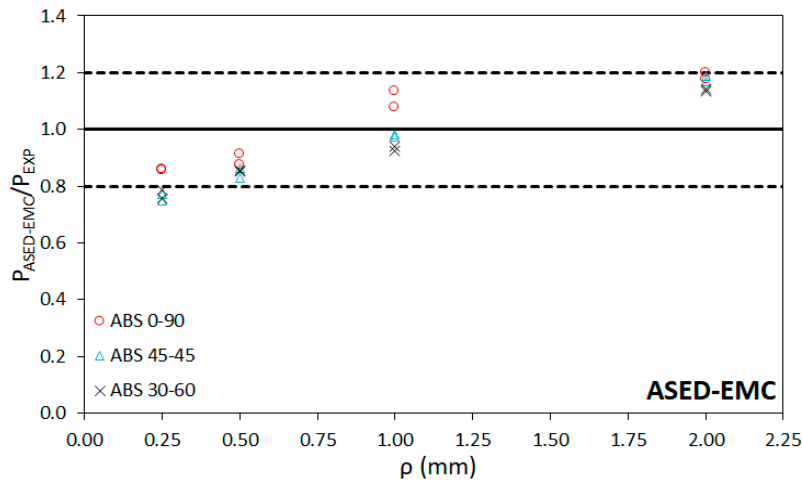
Figure 8. Comparison between fracture load predictions using ASED-EMC and experimental frac- ture loads.